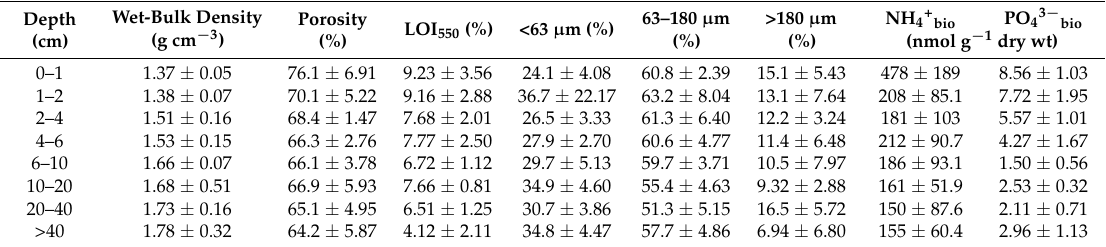
Table 1. Depth profiles of physicochemical parameters in surface sediments of Saltwater Creek (mean ± standard deviation; n =